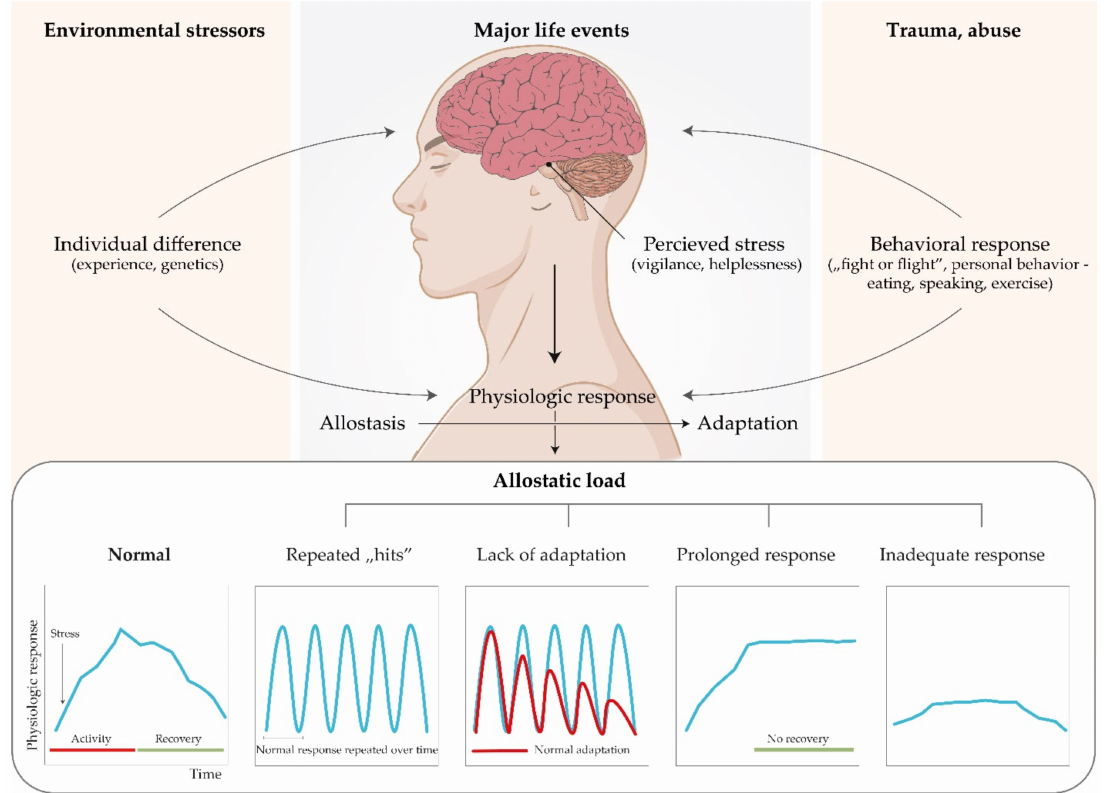
Figure 1. The stress response and development of allostatic load. The top panel shows the perception of stress and the factors influencing it. The bottom panel illustrates normal allostatic response and allostatic load. Modified from McEwen, 2007 [9]. The image was created with the Adobe Illustrator CC (Version 23.0.1.; Adobe Inc., San Jose, CA, USA, 2019)